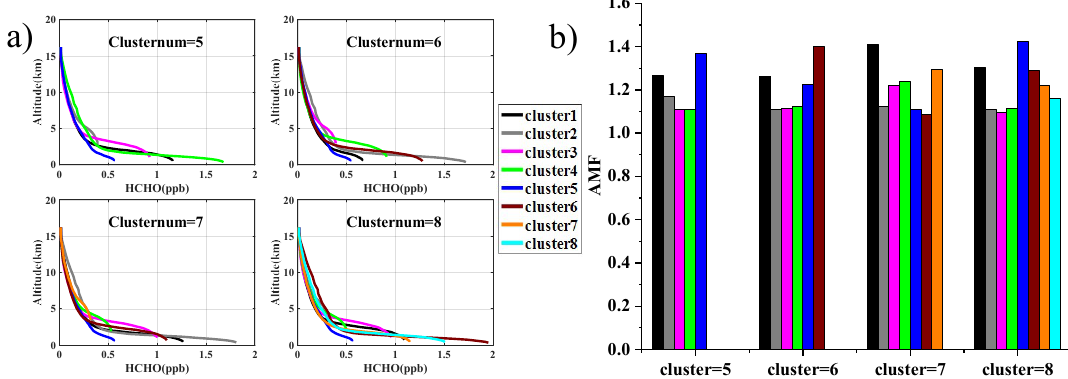
Figure 6. ( a ) HCHO profile clusters (N HCHO : 5–8); ( b ) air mass factor (AMF_ corresponding to the HCHO profiles in panel ( a ). Each colour bar corresponds to the HCHO profile of the same colour.